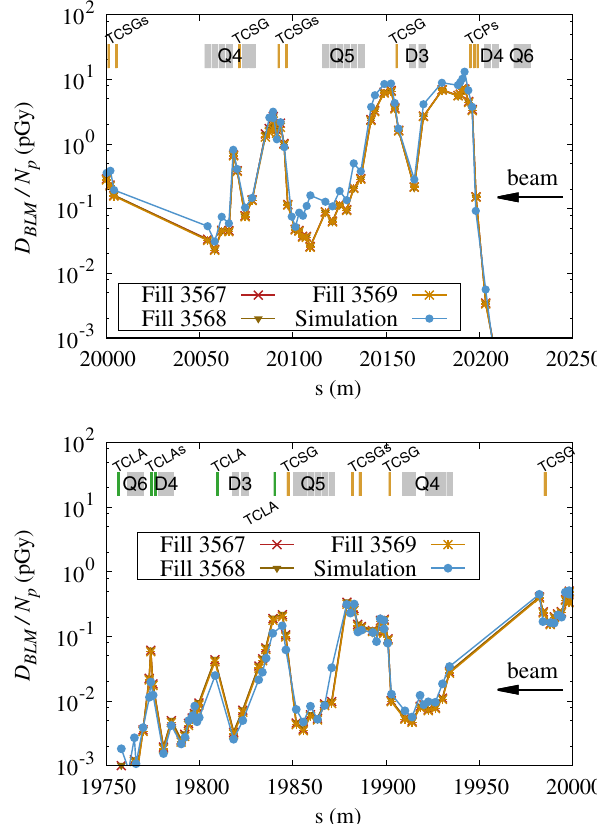
FIG. 9. Comparison of simulated and measured BLM signals induced by 4 TeV proton losses in the betatron cleaning insertion. The top and bottom figures show the right and left side of the insertion region, respectively. The beam direction is from the right to the left. The positions of primary and secondary collimators (TCPs and TCSGs), tungsten absorbers (TCLAs), dipoles (D3 and D4), and quadrupoles (Q4 – Q6) are illustrated in the upper part of the graphs. All signals are expressed per proton lost in the collimation system. The statistical error of simulation results is generally smaller than 10% for dose values above ∼ 10 − 2 pGy but can be as large as a factor of a few for dose values below 10 − 2 pGy. The measurement are labeled by the corresponding LHC fill number, which is an unique identifier for a LHC